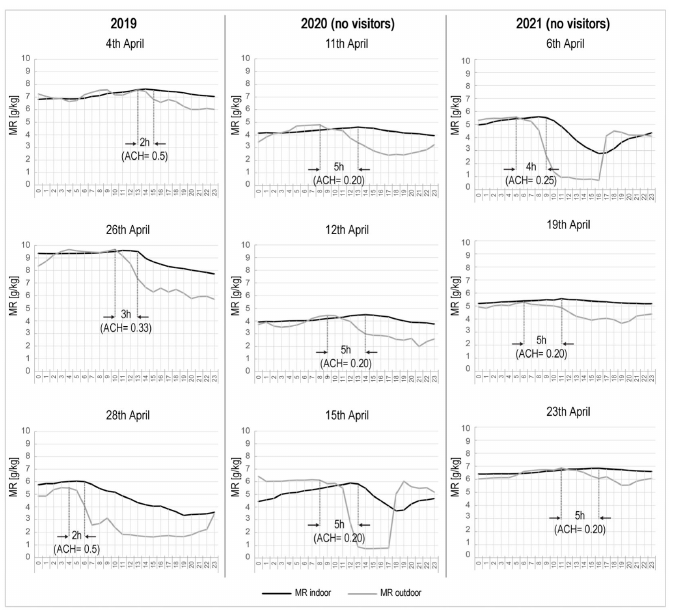
Figure 9. Estimation of time elapsed between outdoor and indoor mixing ratio peaks for some sample days of April 2019, 2020 and